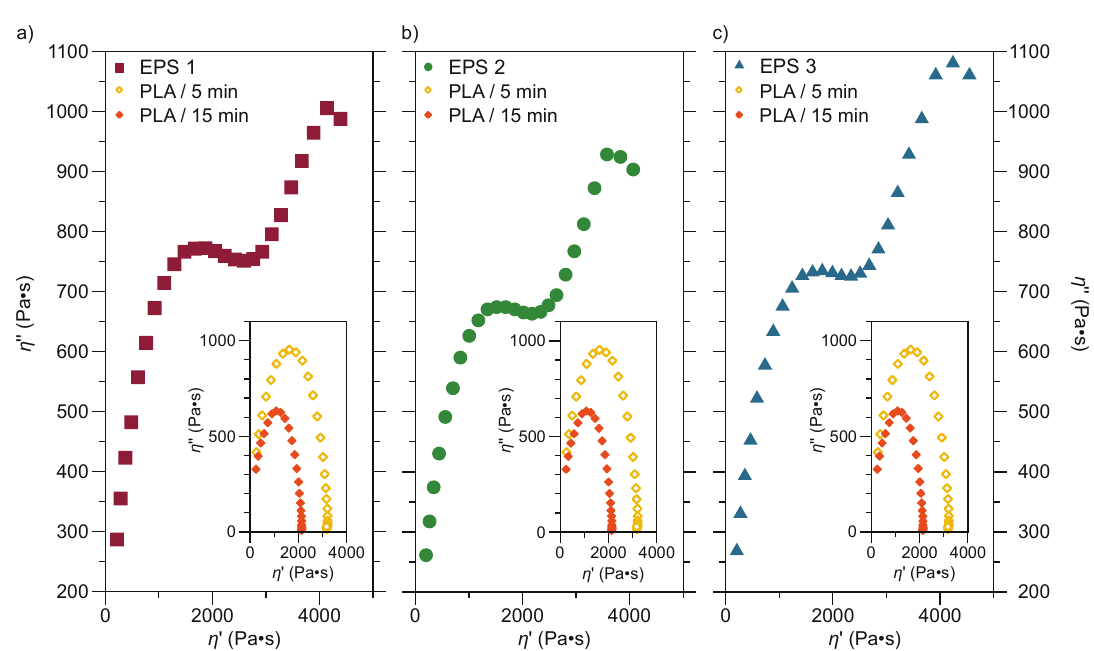
Figure 7. Cole-Cole plots of neat PLA and ternary blends. ( a ) EPS 1; ( b ) EPS 2; ( c ) EPS 3.